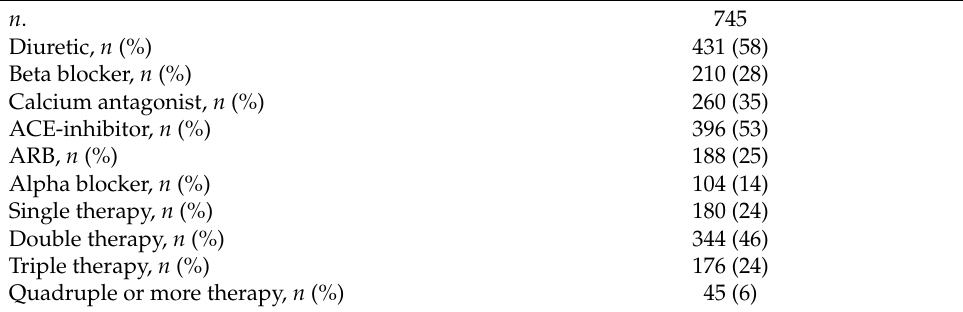
Table 3. Antihypertensive therapy of the study population.